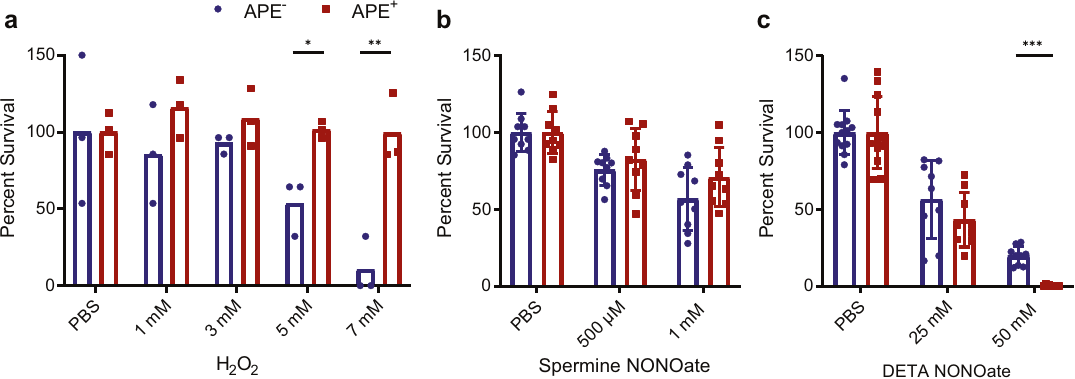
Fig. 5 APE Ec expression protects from oxidative, but not from nitrosative challenge. a Percent survival upon exposure to different concentrations of hydrogen peroxide (H 2 O 2 ) is calculated from colony-forming units after a 60 min H 2 O 2 challenge for the APE Ec expressing (APE + , red) versus control strain (APE − , blue) relative to the PBS control. The reactions were stopped by adding an excess of catalase. b APE Ec expression does not mediate protection from reactive nitrogen challenge. Percent survival is calculated from colony-forming units after a 1 – 2 h spermine NONOate challenge for the APE Ec expressing (APE + ) versus control strain (APE − ) relative to the PBS control. c Percent survival of APE + and APE − strains after 1 – 2 h of DETA NONOate challenge. PBS = phosphate buffered saline ( n = 3 – 5 repeats; error bars represent SD; * p < 0.05, ** p < 0.01, and *** p < 0.001 by unpaired t -test with Welch ’ s correction).